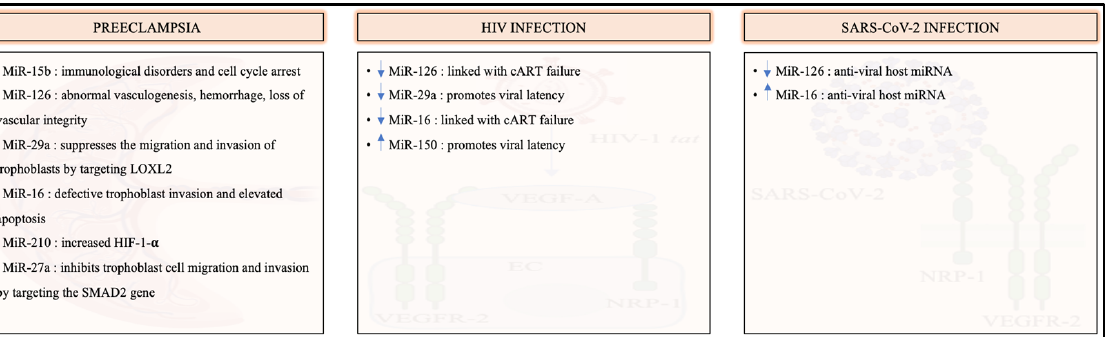
Figure 3. MicroRNA regulation in PE, HIV, and COVID-19. Abbreviations: lysyl oxidase homolog 2 (LOXL2), hypoxia inducing factor-1- α (HIF-1- α ), combined antiretroviral therapy (cART).